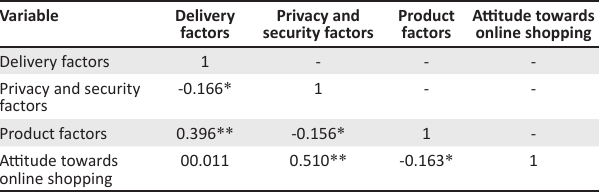
TABLE 2: Correlation amongst the factors. Variable